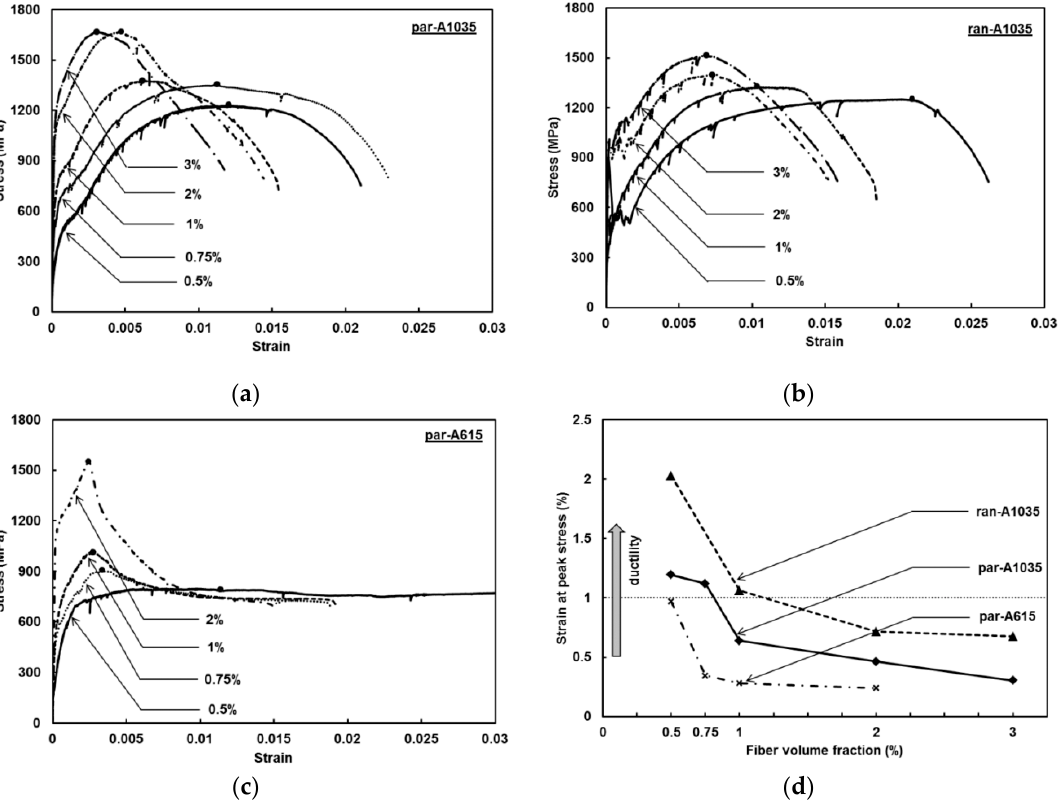
Figure 17. E ff ect of V f on stress versus strain response: ( a ) A1035 bars with parallel fiber orientation; ( b ) A1035 bars with random fiber orientation; ( c ) A615 bars with parallel fiber orientation; ( d ) Ductility vis-à-vis fiber volume fraction.